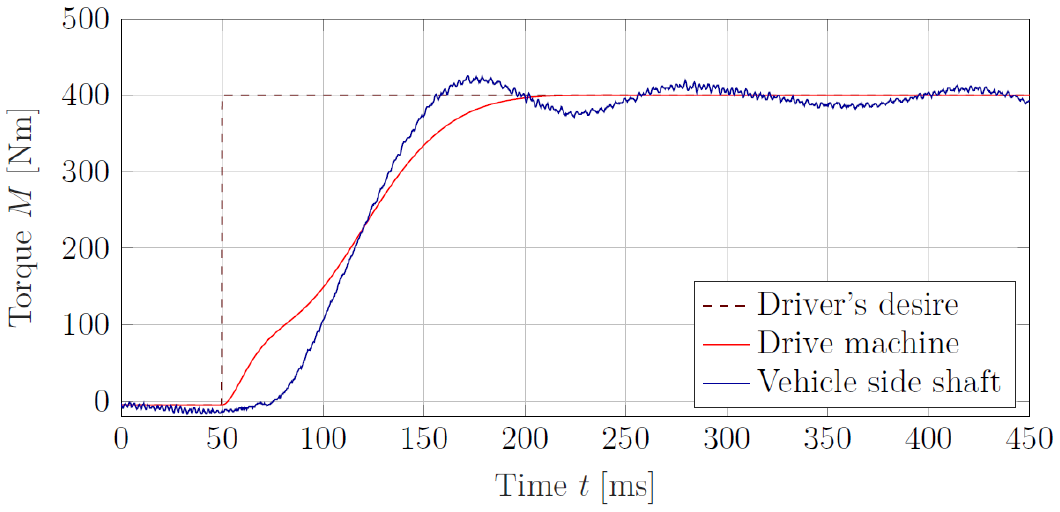
Figure 12. Torque curves as a result of the setpoint step in the driver′s desired torque with prefilter while tip-in.